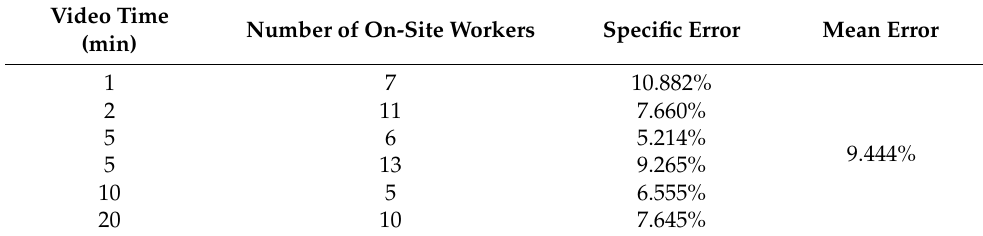
Table 2. Mean error of worker’s safety status monitoring.